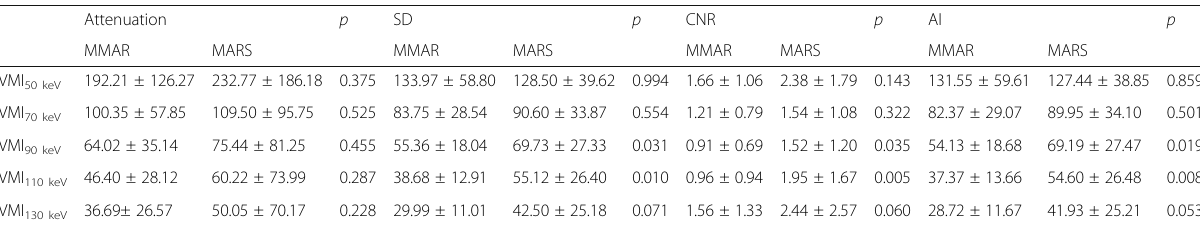
Table 1 Attenuation, SD, CNR, and AI in two groups at different energy levels ( x ± s , n = 30)